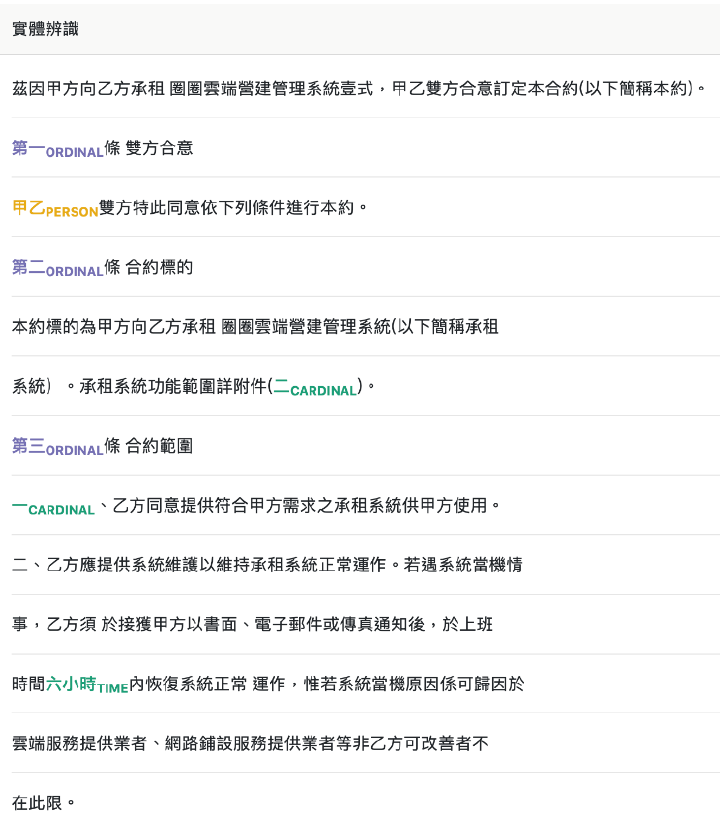
Figure 7. Outputs of CKD (Contract keyword in Chinese showing parties, duration, ordinal numbers, technologies used, and so on in the contract for easier and faster communication for project management).